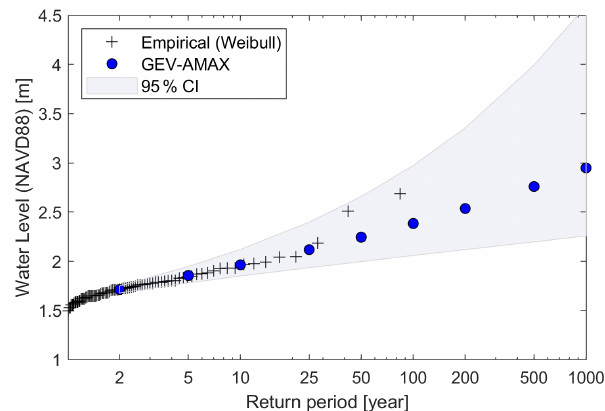
Figure 5. Return water levels (WLs) for the Fort Pulaski station in the Savannah, GA (NOAA – 8670870). Plotting positions (black crosses) are derived from the Weibull formula based on annual block maxima time series (AMAX) and comparable to the general- ized extreme value (GEV) distribution (blue circles). The 95% con- fidence intervals (CIs) for the distribution parameters of the GEV distribution are shown with a blue-shaded